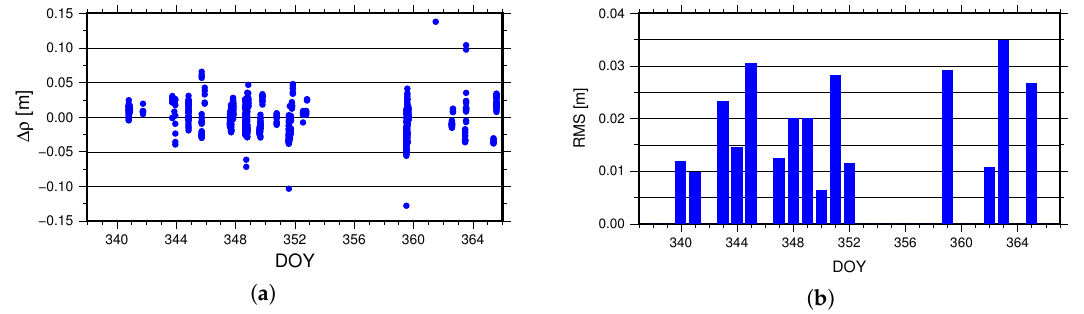
Figure 12. ( a ) is the distribution of SLR residuals for TG02 ZD reduced-dynamic POD during DOY